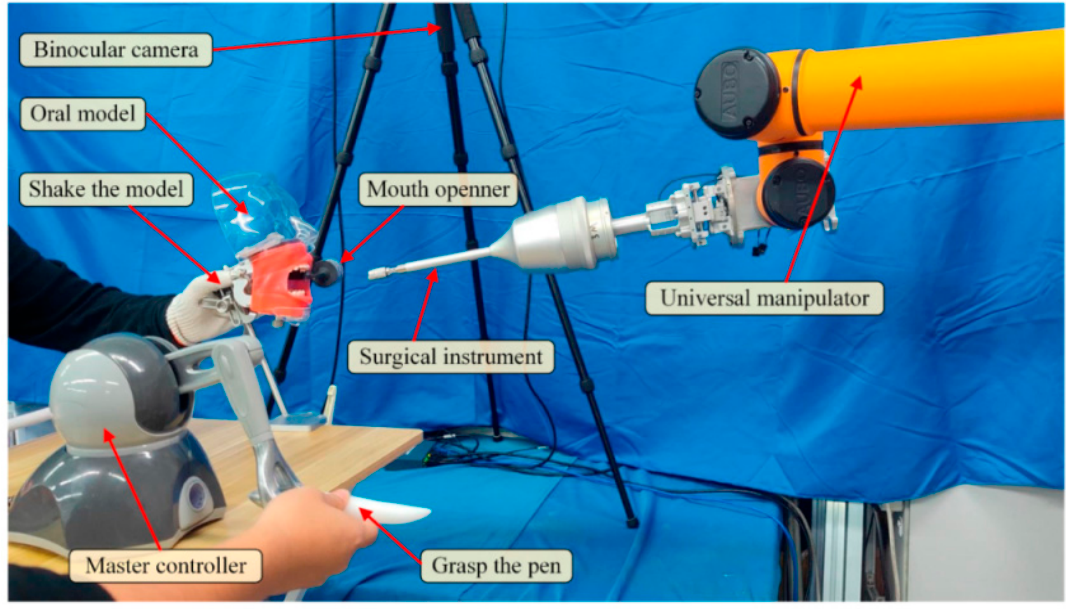
Figure 18. The experimental setup. Experiments are conducted with the following three groups: static and manual feeding, dynamic and manual feeding, and dynamic and automatic feeding. The motion process of the three groups is shown in Figure 19a,b and Figure 20,